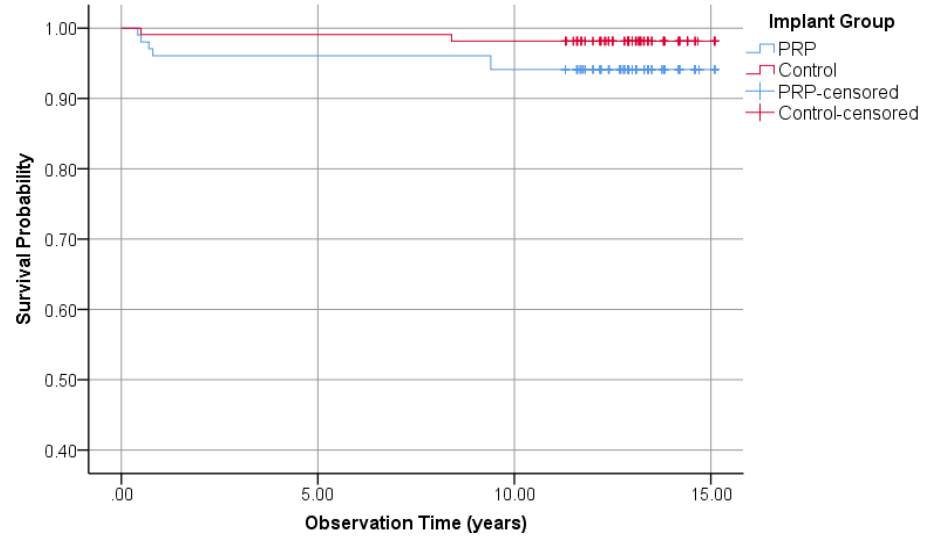
Figure 2. Kaplan–Meier survival probabilities of 210 investigated implants, 102 PRP, and 108 control